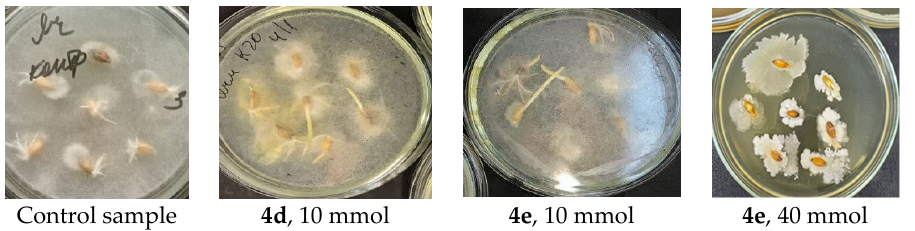
Figure 7. Growth of microflora on barley seeds treated with compounds.